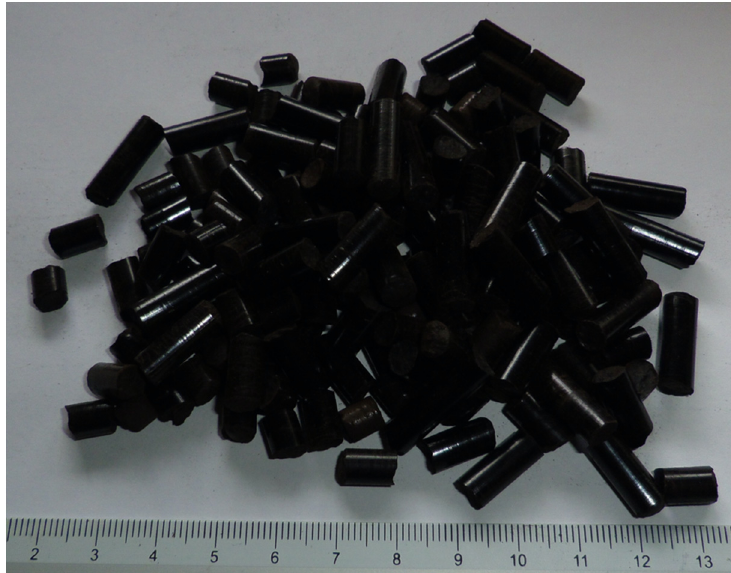
Figure 4. Appearance of the final product. Despite the excellent appearance, this material is not